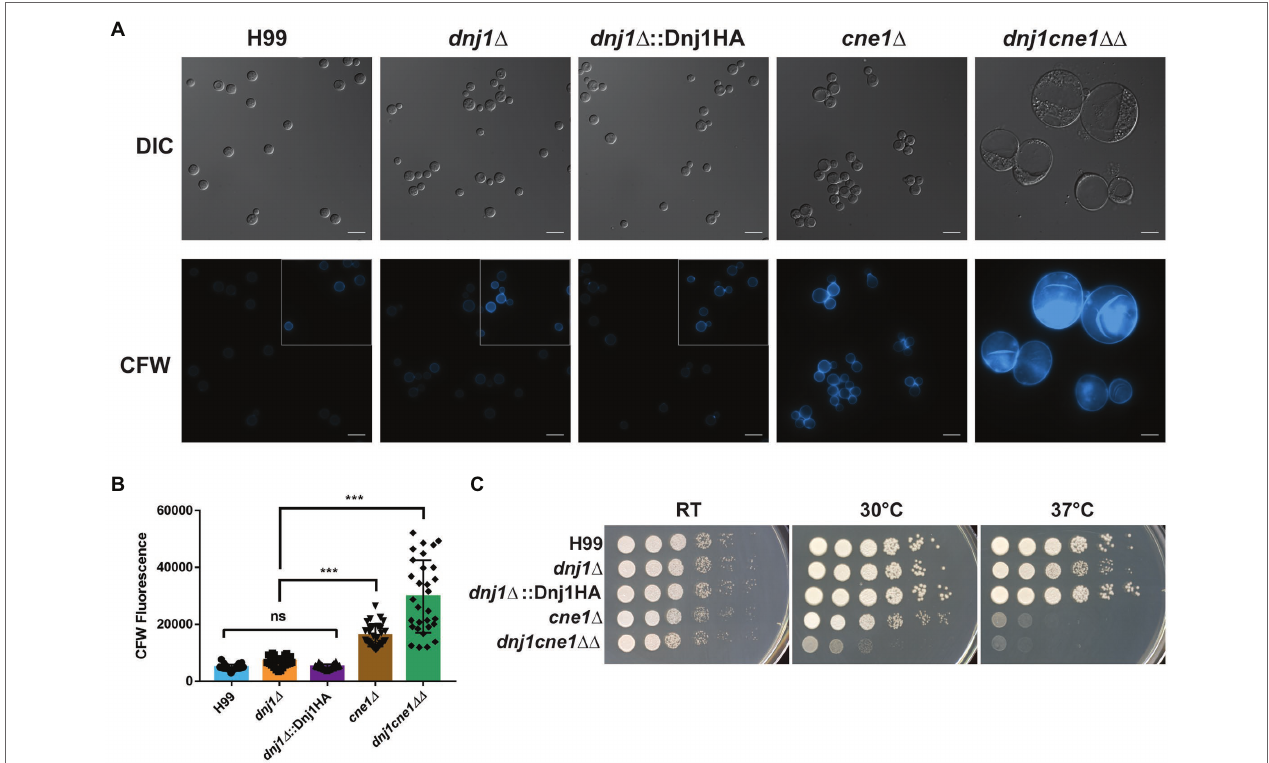
FIGURE 3 | Dnj1 and calnexin are required for robust growth under routine culture conditions. Calnexin ( CNE1 ) was deleted in the background of a dnj1 ∆ deletion mutant and the resultant double deletion mutant grew poorly under routine culture conditions. (A) Microscopy of the wild type (H99), single knockouts ( dnj1 ∆ and cne1 ∆ ), Dnj1HA complement, and double knockout ( dnj1cne1 ∆∆ ) grown overnight in YPD under routine conditions (30 ° C). Cells stained with 100 μ g/ml of calcofluor white (CFW) are shown to reveal changes in surface exposed chitin in the mutants. The images of all CFW stained cells have consistent brightness and contrast applied to all images to highlight the differences in staining. However, since H99, dnj1 ∆ , and dnj1 ∆ ::Dnj1HA had less CFW staining, the subsections in the gray boxes have enhanced brightness to show the morphology of the cells for these strains. Bar = 10 μ m. (B) Quantification of the average fluorescence intensity from CFW per cell for 30 cells was measured for each genetic background. Each dot represents a measured cell, the mean is represented by the bar height and the SD is shown with error bars. Statistical significance was determined using a one-way ANOVA with Tukey’s multiple comparisons (ns, not significant; *** p < 0.005). (C) Spot assays of serially diluted strains on YPD plates incubated at different temperatures (RT, 30 or 37 ° C) for 2 days before being scanned. Microscopy images and spot assays are representative of three independent